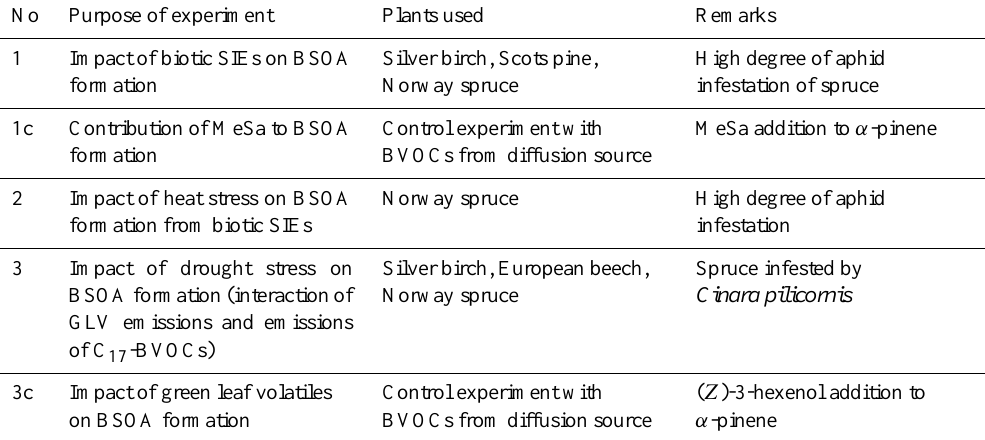
Table 1. Overview over experiments with trees and control experiments.